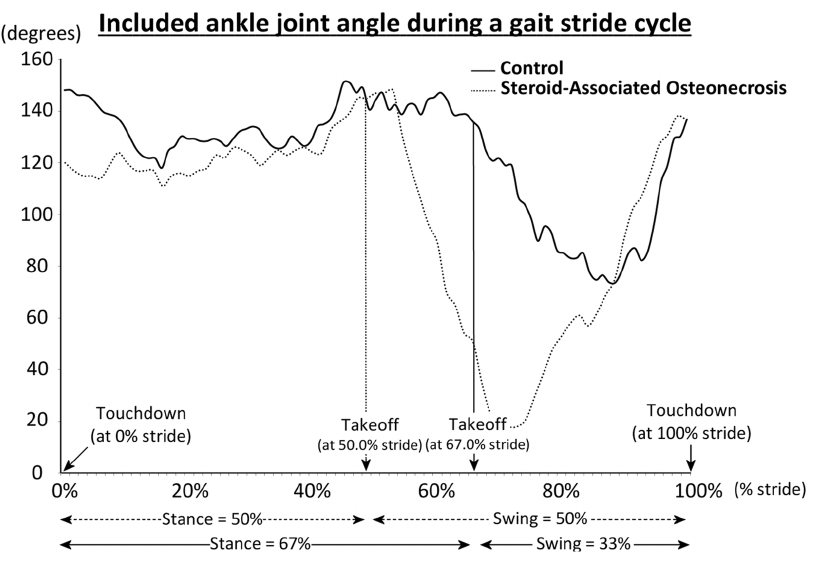
Figure 3. High-speed video gait analysis for the included ankle joint angle during a gait stride cycle compared between a representative normal emu and an emu with SAON-induced hip joint collapse (confirmed after its sacrifice). The major difference was shown in the ankle joint during takeoff at 67.0% stride.